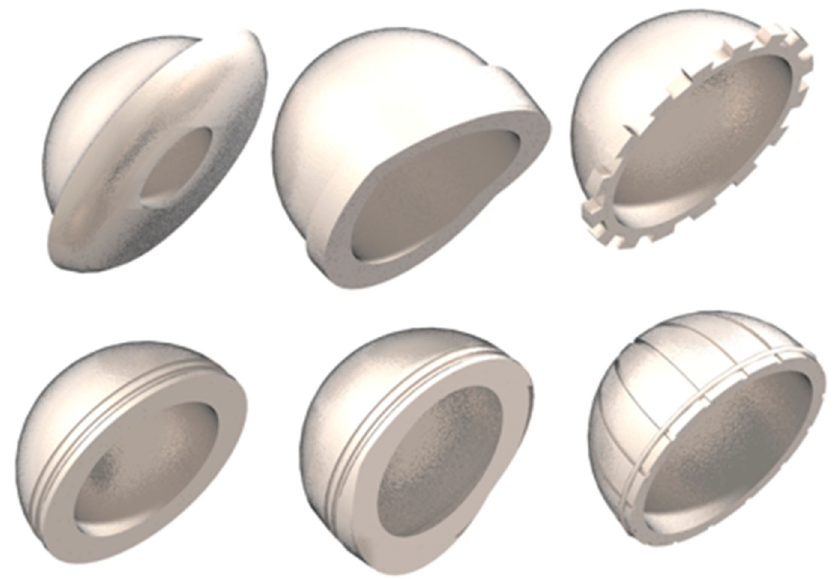
Figure 3. Some of the designs that are achieved with polyethylene for the acetabular cup.